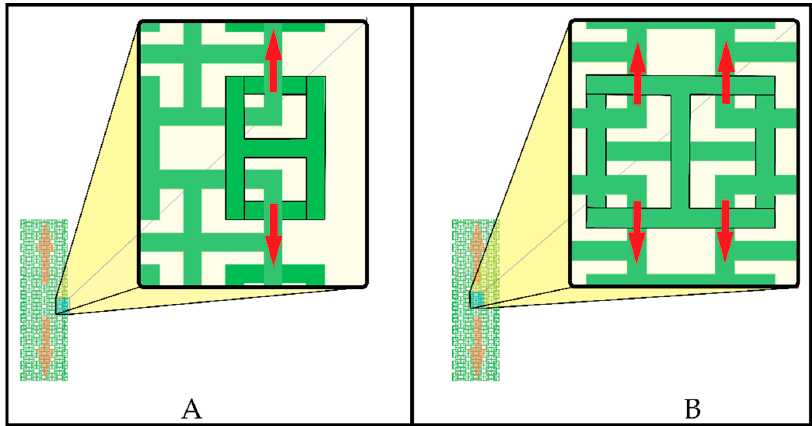
Figure 6 . Stress conditions: ( A ) edge elements; and ( B ) inner elements. Figure 6. Stress conditions: ( A ) edge elements; and ( B ) inner